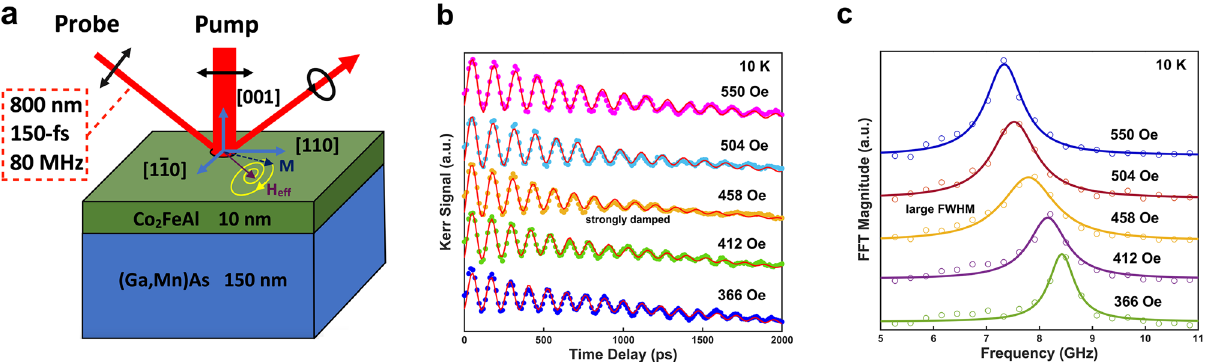
Figure 1. ( a ) Schematic of TRMOKE measurement geometry, depicting the structure of the sample and the magnetization M precessing around the effective field H eff in Co 2 FeAl/(Ga,Mn)As bilayer in a canted magnetization configuration with H applied along hard axis 1–10 . ( b ) TRMOKE data from Co 2 FeAl/(Ga,Mn)As bilayer under the different intensity of the applied field. ( c ) FFT analysis for magnetization precession frequency under the different intensities of the applied field, where the solid lines represent the FFT peaks fitted by Lorentz